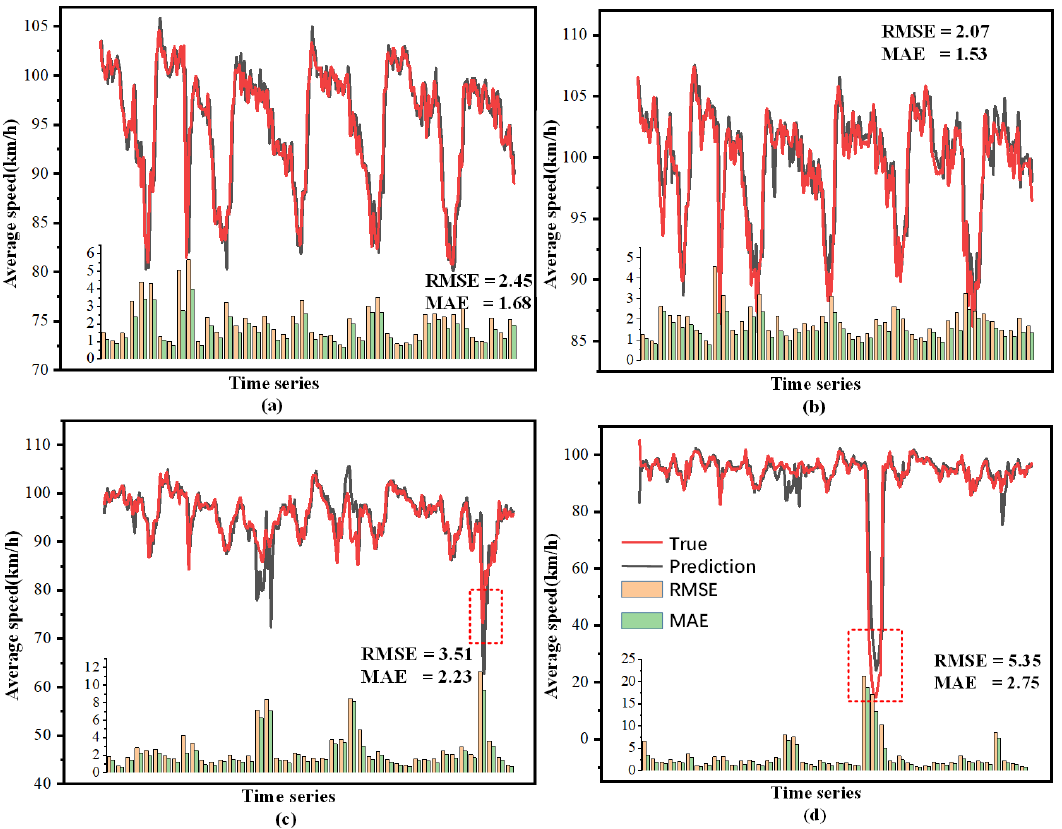
Figure 11. Visualization results for 15 min. ( a ) Section a ( b ) Section b ( c ) Section c ( d ) Section